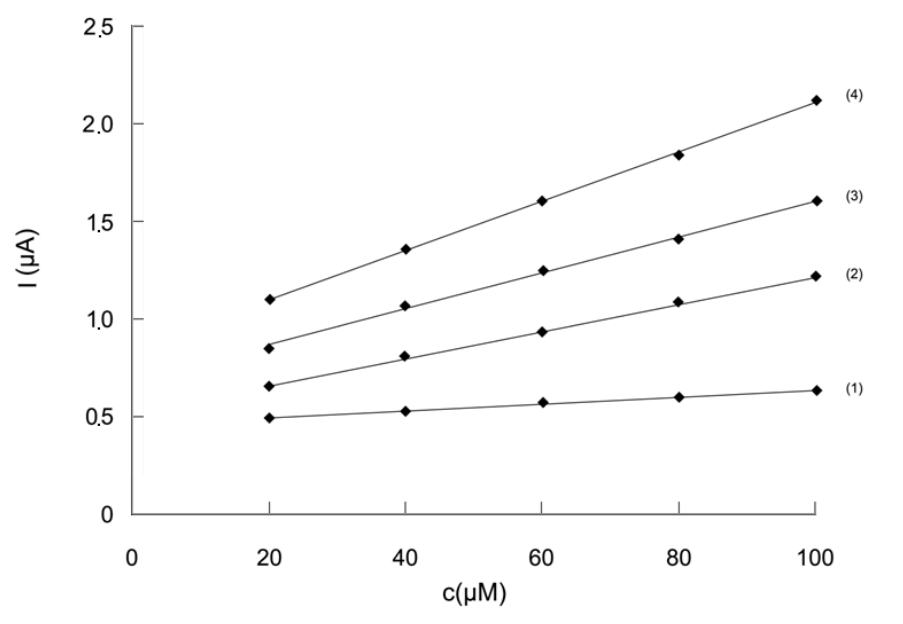
Figure 5 . The analytical response plotted against DPPH· concentration at different values of Δ E: (1) 50 mV, (2) 100 mV, (3) 150 mM, (4) 200 mV; DPPH concentration = 110 µM. (for details see